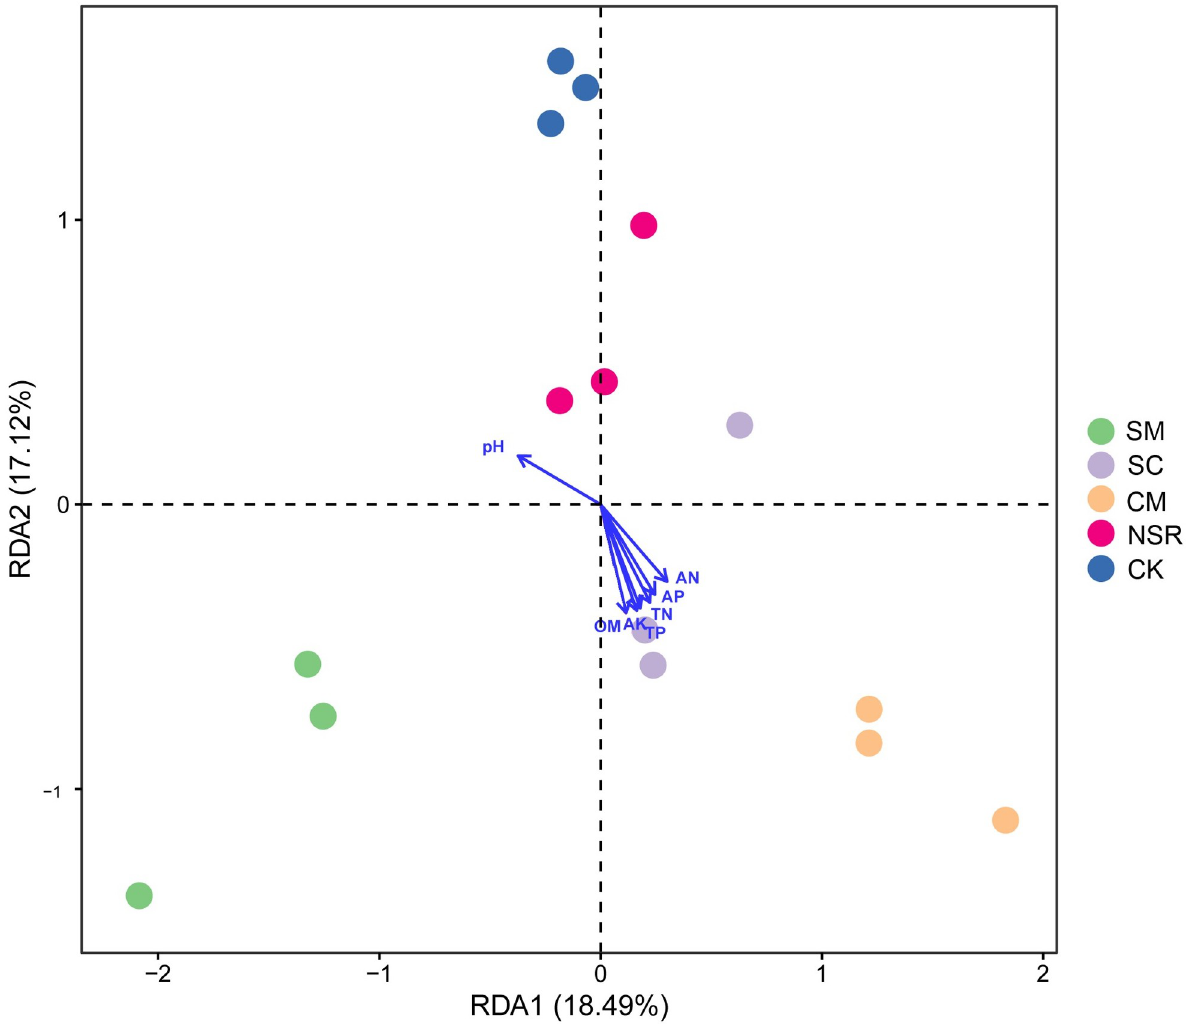
Fig 6. Redundancy analysis between soil samples based on